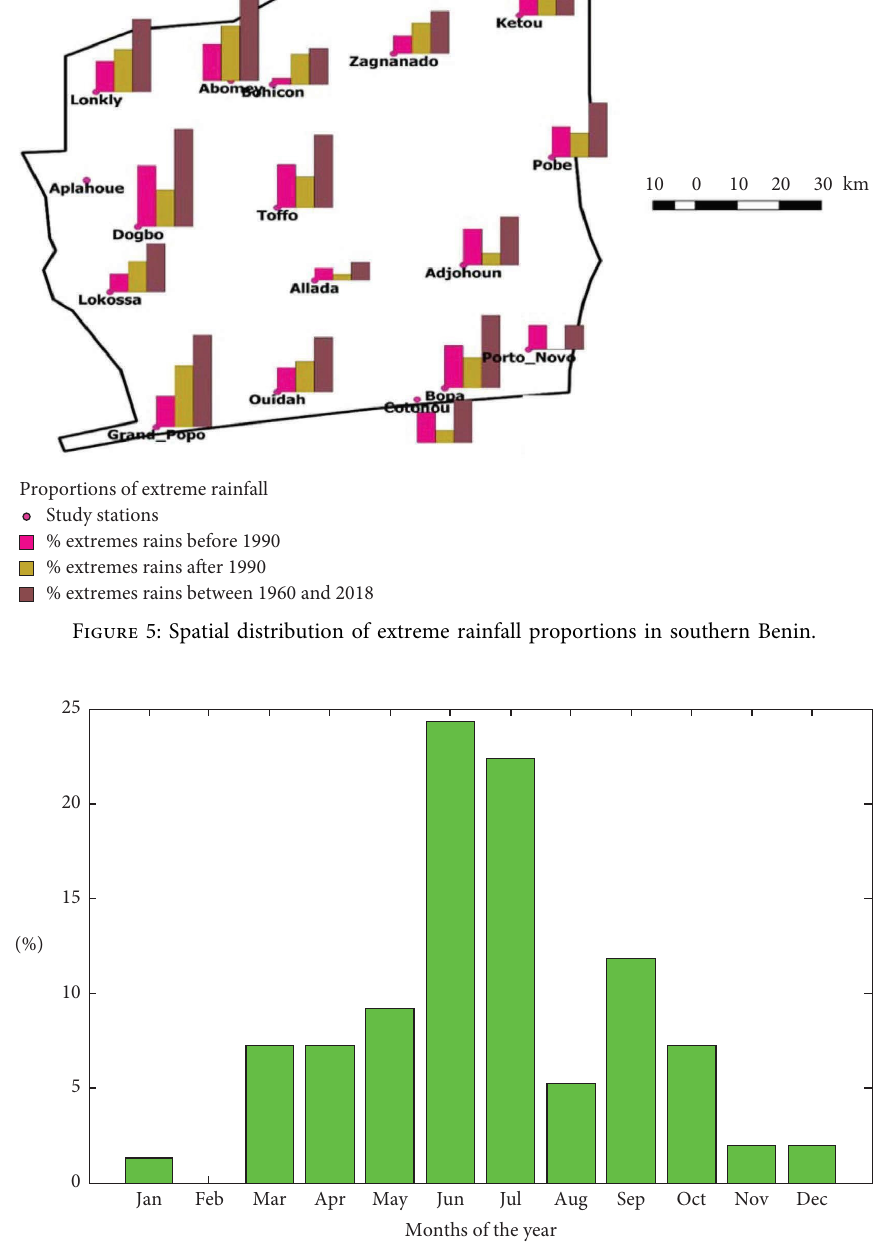
Figure 6: Proportions of monthly extreme rainfall in southern